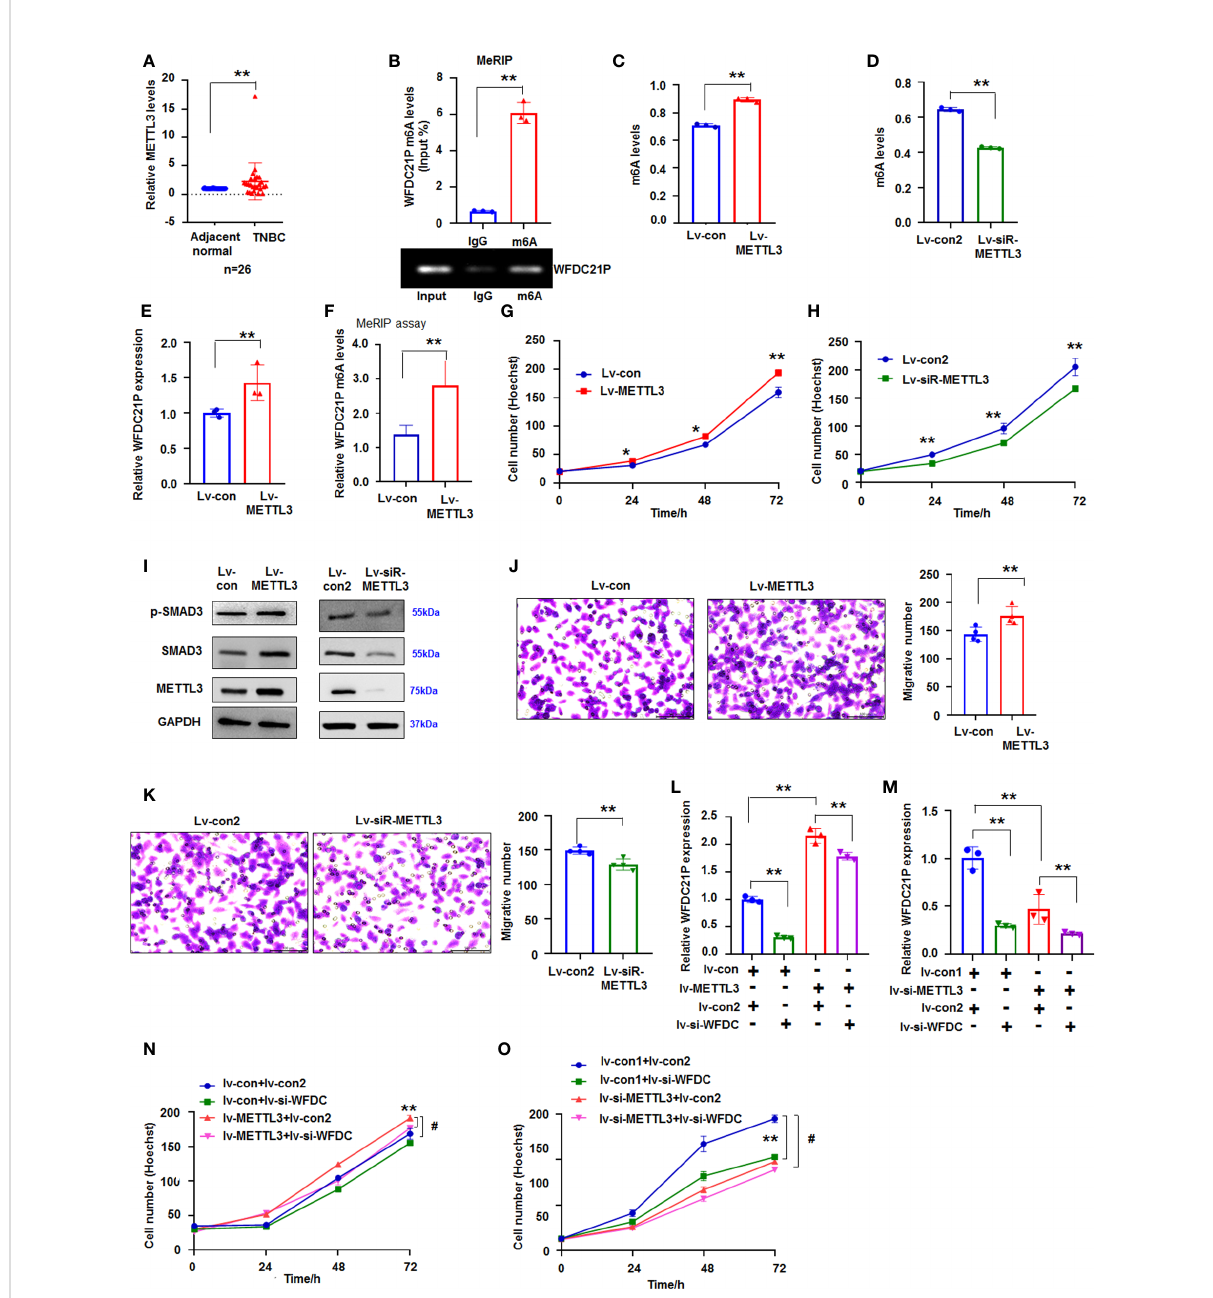
FIGURE 6 Effect of METTL3 on WFDC21p m6A and cell growth. (A) qRT-PCR detection of METTL3 levels in TNBC tissues. Data are shown as median (interquartile range), ** p < 0.01; n=26, Mann – Whitney U test. (B) MeRIP analysis of WFDC21p m6A levels in SUM159 cells. Data are expressed as the mean ± SD of triplicate experiments. ** p < 0.01; Student ’ s t-test. (C, D) Effect of METTL3 overexpression or downregulation on m6A levels in SUM159 cells, respectively. Data are expressed as the mean ± SD of triplicate experiments. ** p < 0.01; Student ’ s t-test. (E) The effect of METTL3 overexpression on WFDC21P levels in SUM159 cells. Data are expressed as the mean ± SD of triplicate experiments. ** p < 0.01; Student ’ s t-test. (F) MeRIP assay. METTL3 overexpression increased WFDC21P m6A levels in SUM159 cells. Data are expressed as the mean ± SD of triplicate experiments. ** p < 0.01; Student ’ s t-test. (G, H) Effect of METTL3 overexpression or downregulation on SUM159 cell proliferation, respectively. Data are expressed as the mean ± SD of triplicate experiments. * p < 0.05, ** p < 0.01; Student ’ s t-test. (I) immunoblotting analysis. (J, K) Effect of METTL3 overexpression or downregulation on SUM159 cell metastasis, respectively. Data are expressed as the mean ± SD of triplicate experiments. ** p < 0.01; Student ’ s t-test. (L, M) qRT-PCR analysis of WFDC21P levels. Data are expressed as the mean ± SD of triplicate experiments. ** p < 0.01; ANOVA. (N, O) siRNA-WFDC21P reduced the effect of METTL3 on cell growth. Data were expressed as mean ± SD. ** p < 0.01, # p < 0.001;